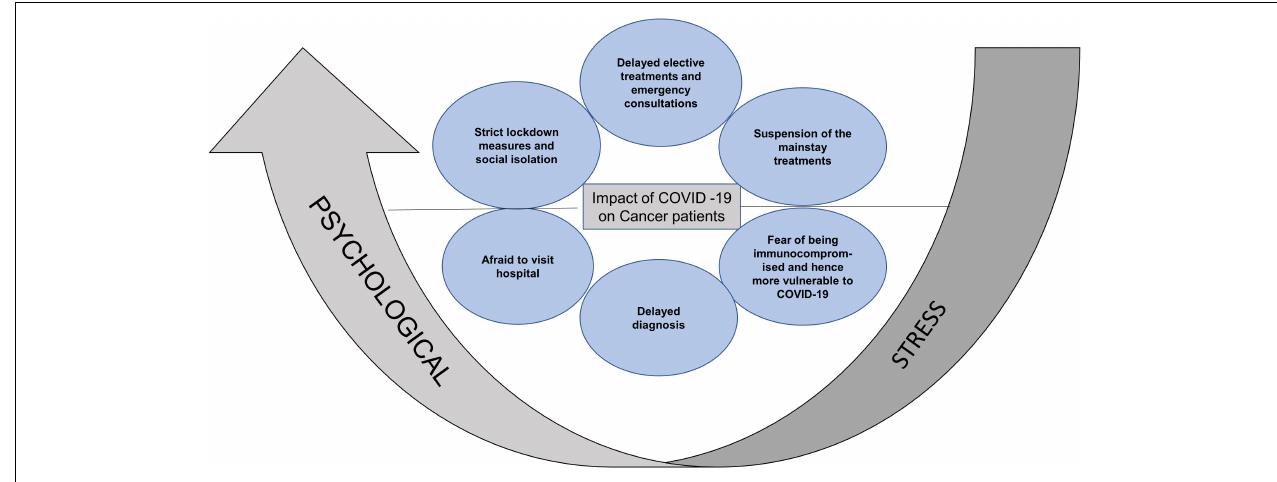
FIGURE 1 | Summary of the reasons for aggravated psychological stress in cancer patients. Strict lockdown measures, social isolation, delayed consultations, suspension of mainstay treatments, fear of increased vulnerability to COVID-19 and limited access to hospital, increased the psychological stress in cancer